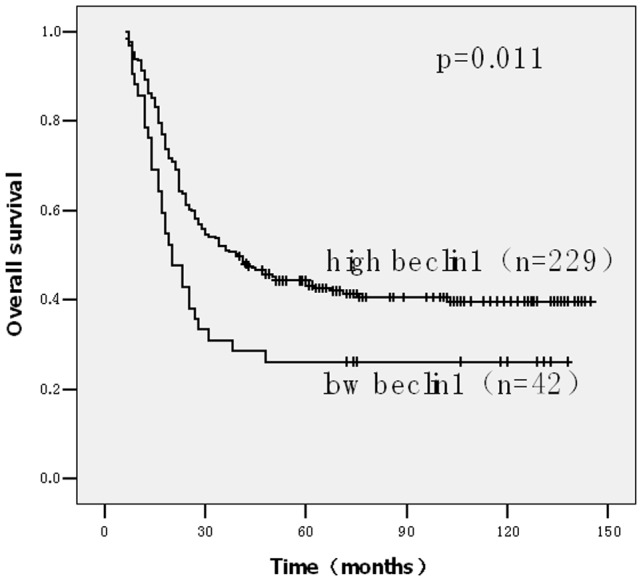
Kaplan-Meier estimates of the probability of survival.Patients with high expression Beclin 1 showed significantly longer overall survival than those with Beclin 1 low expression. (p = .011).